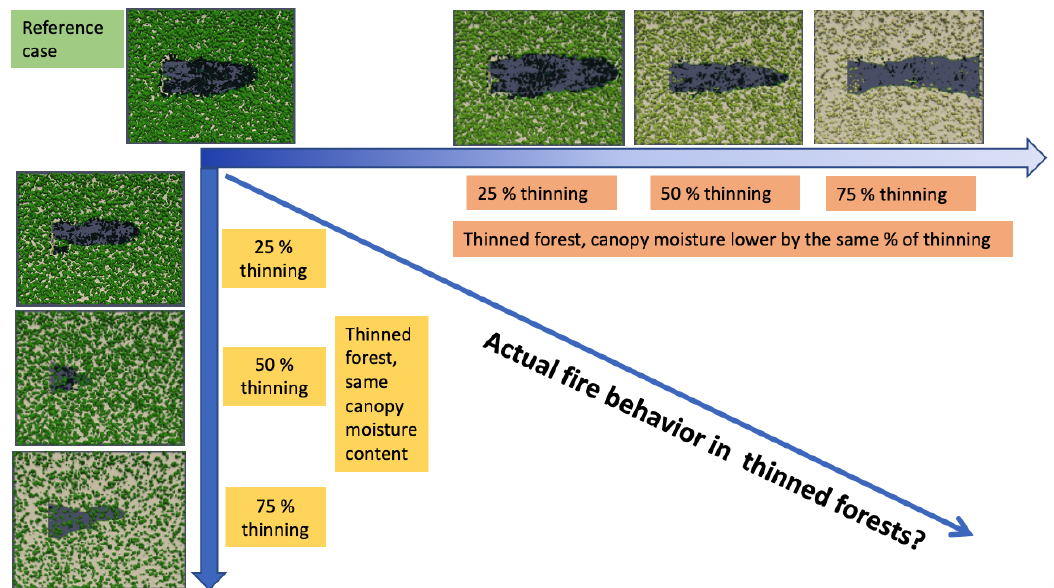
Figure 2. Burnt patterns for the different simulation cases after 400 s. Horizontal axis shows burnt areas for 25%, 50% and 75% thinning cases where canopy fuel moisture is lowered after thinning. Vertical axis shows the three thinning levels, but the moisture content is same as the reference